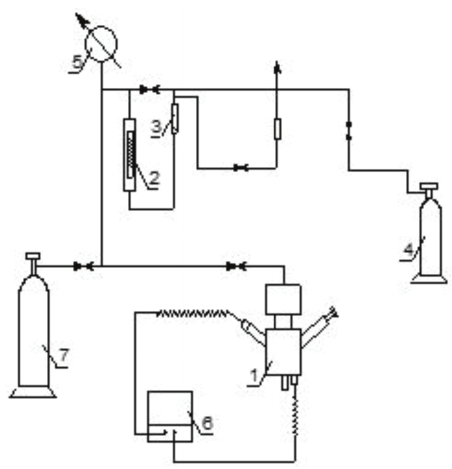
Fig. 1 – Kinetic high-pressure installation; 1 – improved au- toclave Vishnevsky; 2 – measuring burette; 3 – equalizing ca- pacitance; 4 – buffer capacitance; 5 – exemplary manometer; 6 – IRT; 7 – hydrogen balloon